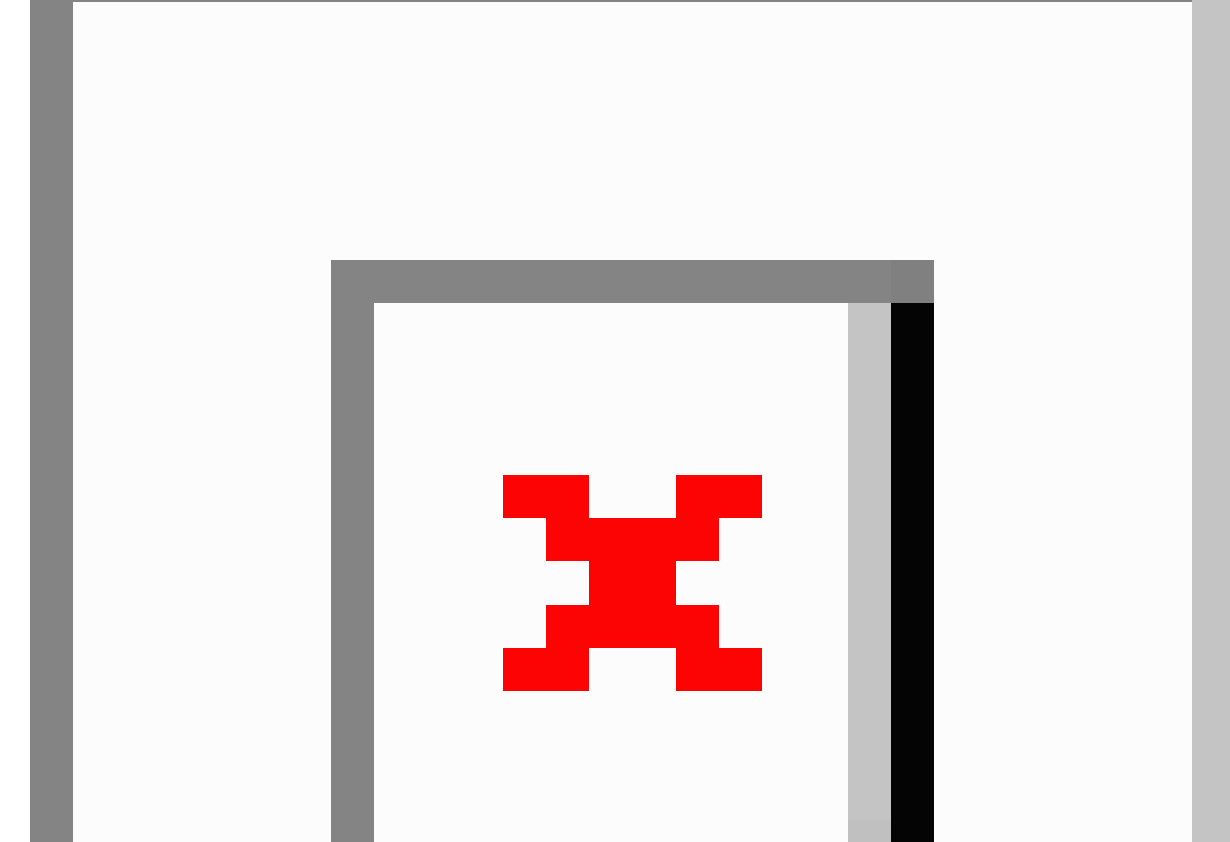
Figure 2. Synopses, systematic reviews, and select studies of evidence-based medicine resources provided in the federated search engine MacPLUS FS (McMaster Premium LiteratUre Service Federated Search); adapted from Agoritsas et al, 2014. ACP: American College of